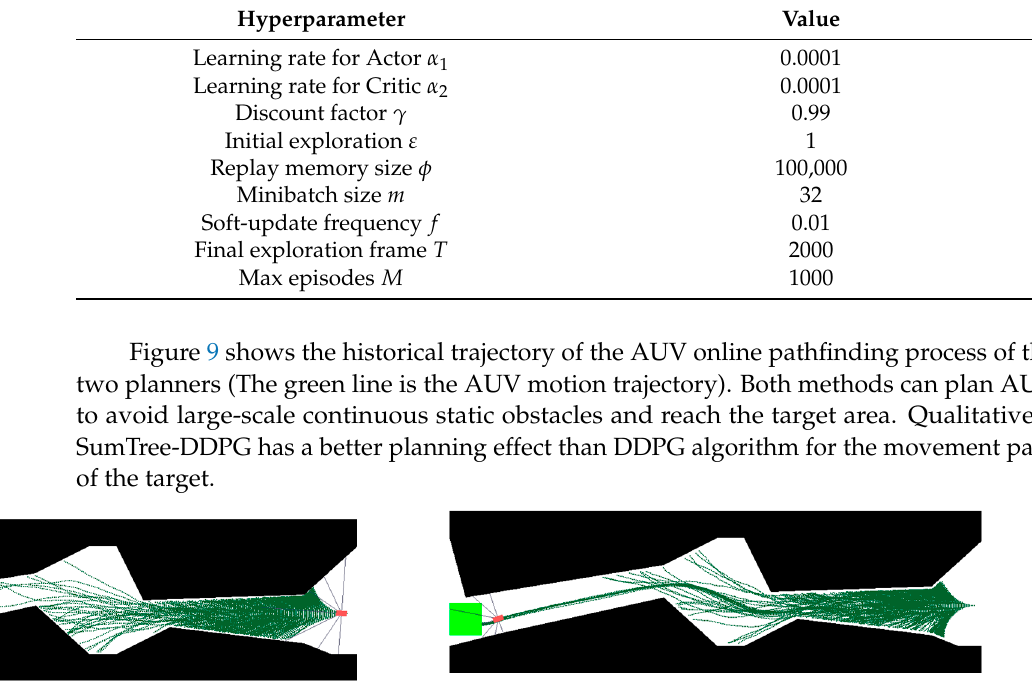
Figure 8. Environment 2. : The walls of unknown underwater canyon; : Target area; : Dynamic ob ‐